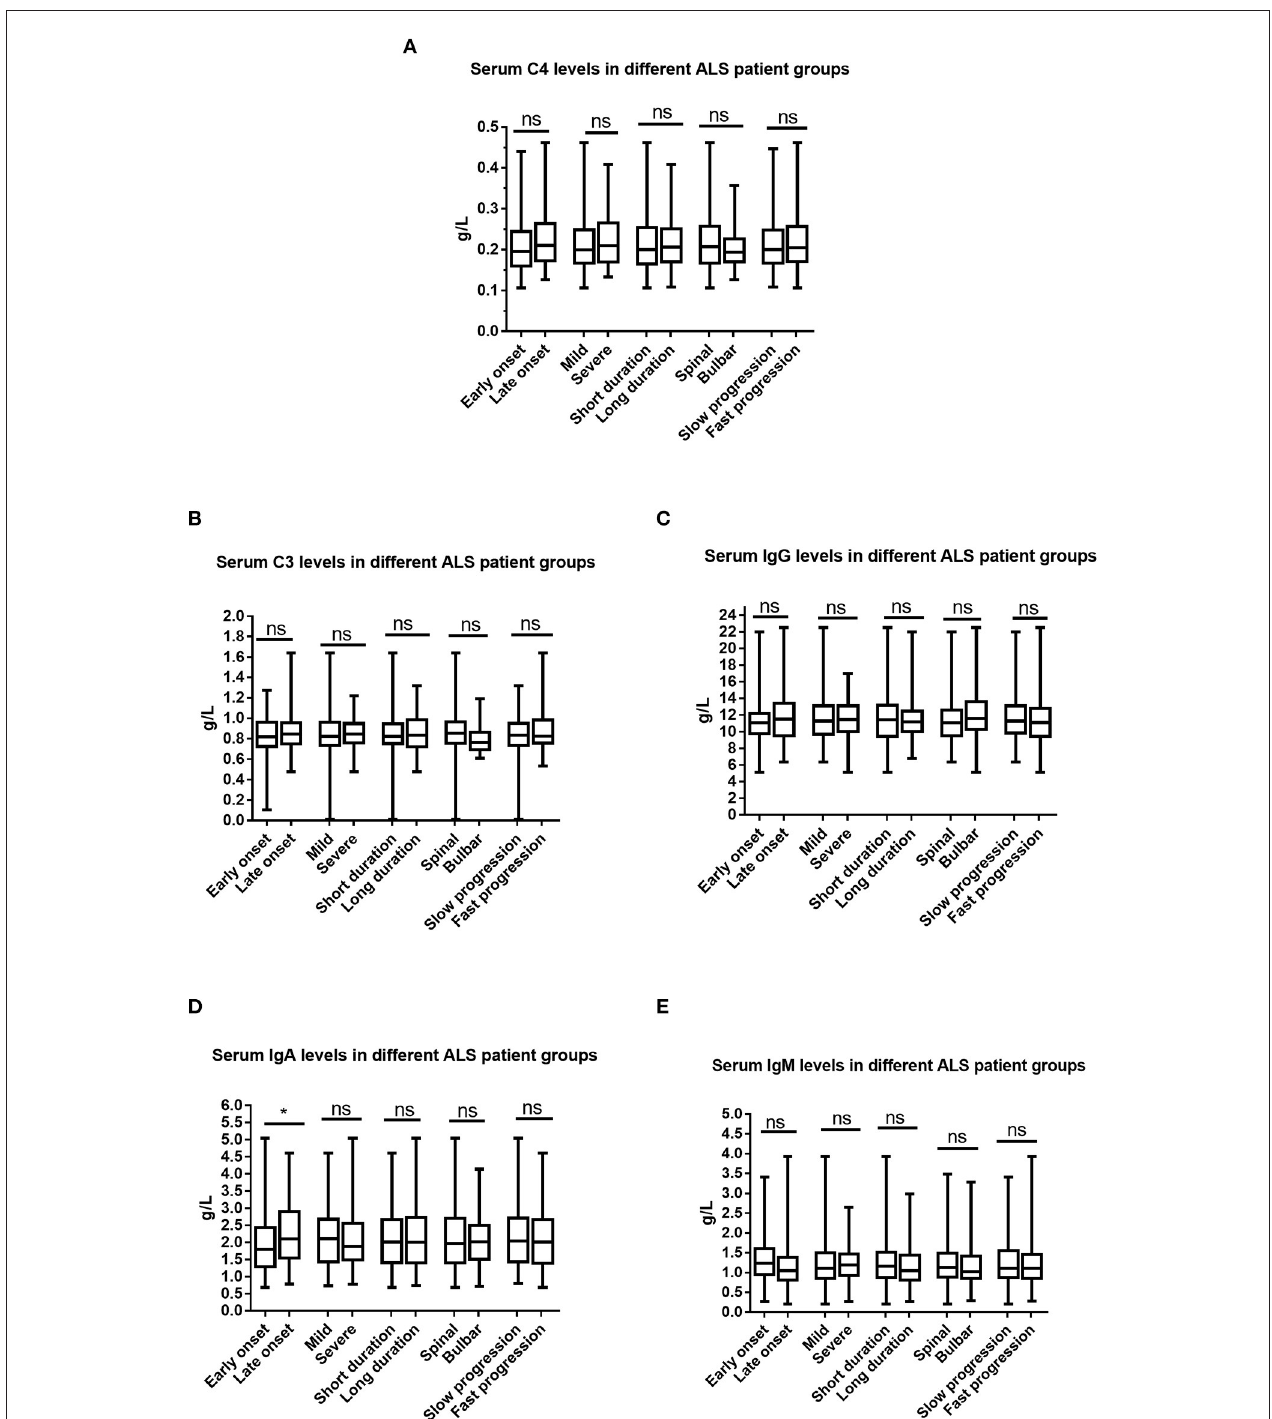
FIGURE 3 | Comparisons of the serum immunoglobulin and complement between different ALS patient groups. (A) Serum C4 between different ALS patient groups. (B) Serum C3 between different ALS patient groups. (C) Serum IgG between different ALS patient groups. (D) Serum IgA between different ALS patient groups. (E) Serum IgM between different ALS patient groups. Ns denotes no significance, * p < 0.05. Early onset indicated ALS patient group with an age at onset of < 55 years old; Late onset indicated ALS patient group with an age at onset of ≥ 55 years old; Short duration indicated ALS patient group with a disease duration of < 12 months, Long duration ALS patient group with a disease duration of ≥ 12 months; Spinal onset indicated ALS patient group with symptoms at onset involving only the spinal cord; Bulbar onset indicated ALS patient group with symptoms at onset involving the bulbar region; Mild indicated ALS patient group with an ALSFRS-R score of ≥ 37; Severe indicated ALS patient group with an ALSFRS-R score of <